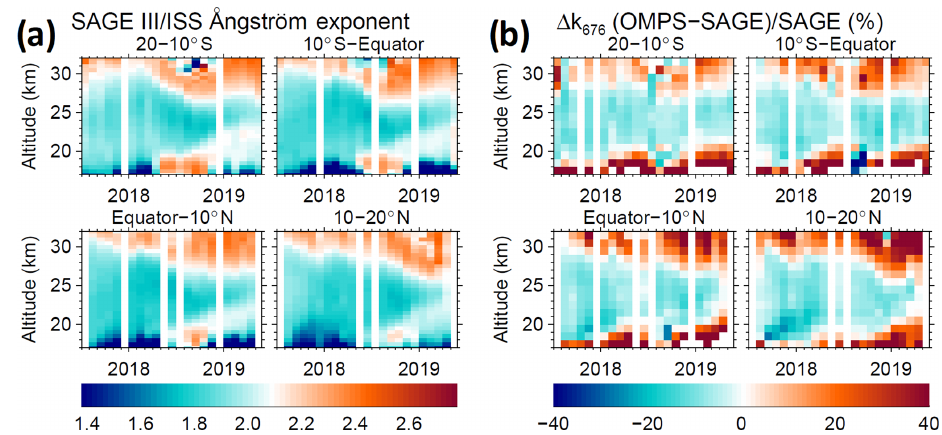
Figure 11. (a) Monthly mean AE and (b) the differences between the SAGE III/ISS and OMPS/LP extinction values at 675nm (in %) as a function of altitude and time for four latitude bands in the tropics. The AE is derived from vertically smoothed SAGE III/ISS data using the aerosol extinction values at 520nm (interpolated) and 1020nm (reported) plotted on a color scale with the baseline value of 2.08 used for the OMPS/LP algorithm at its center.